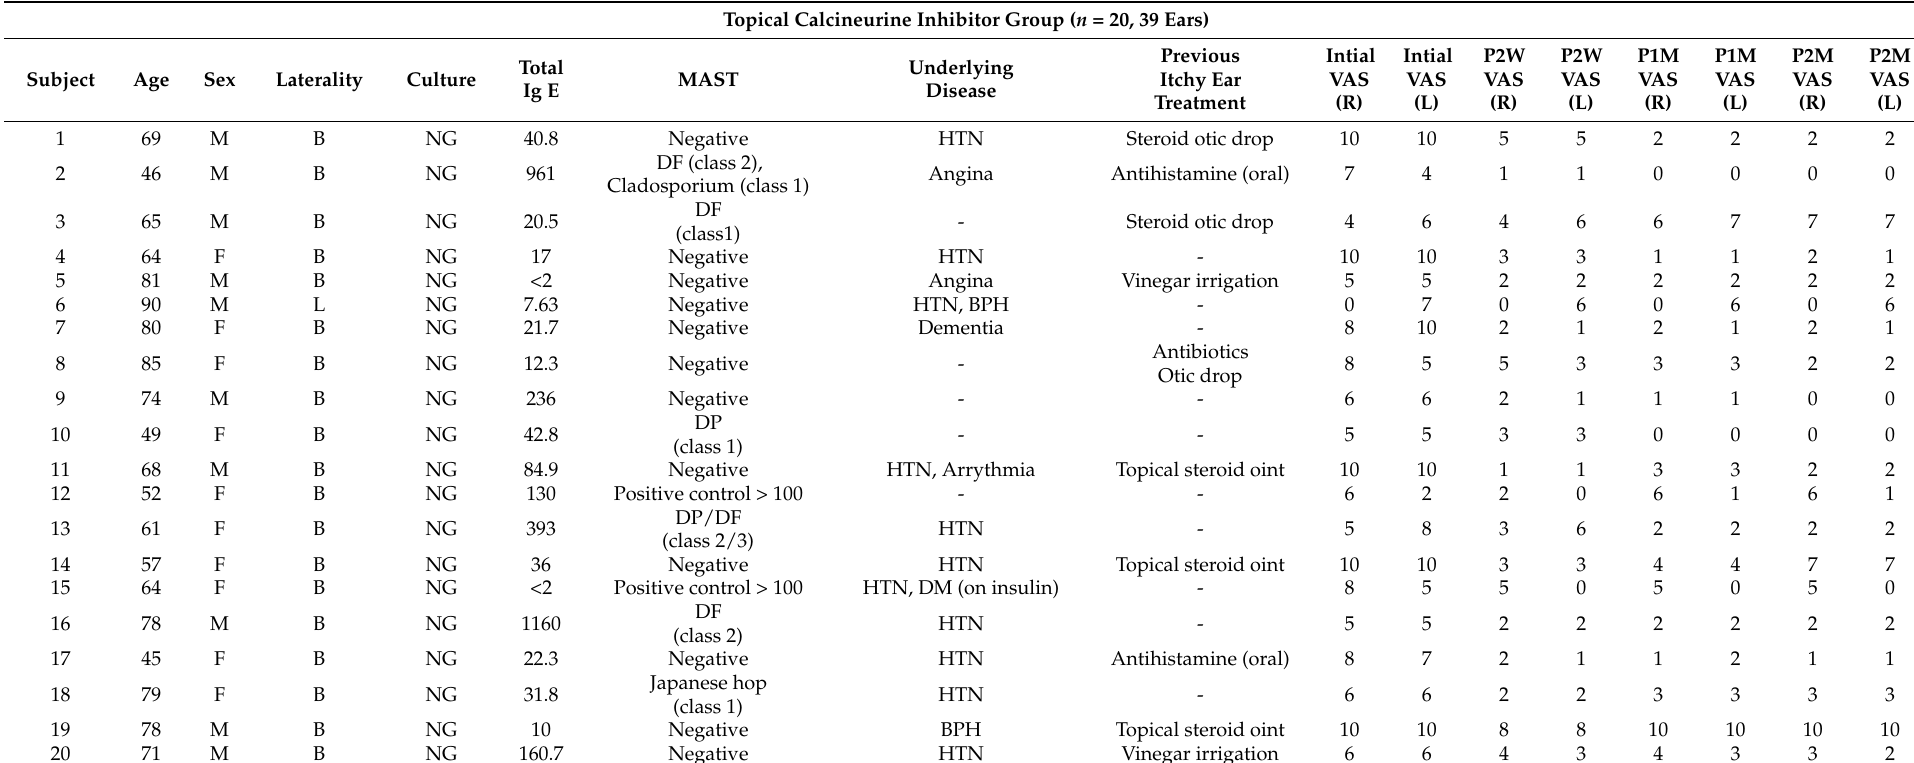
Table 1. Demographics and clinical characteristics in patients with pruritic external auditory